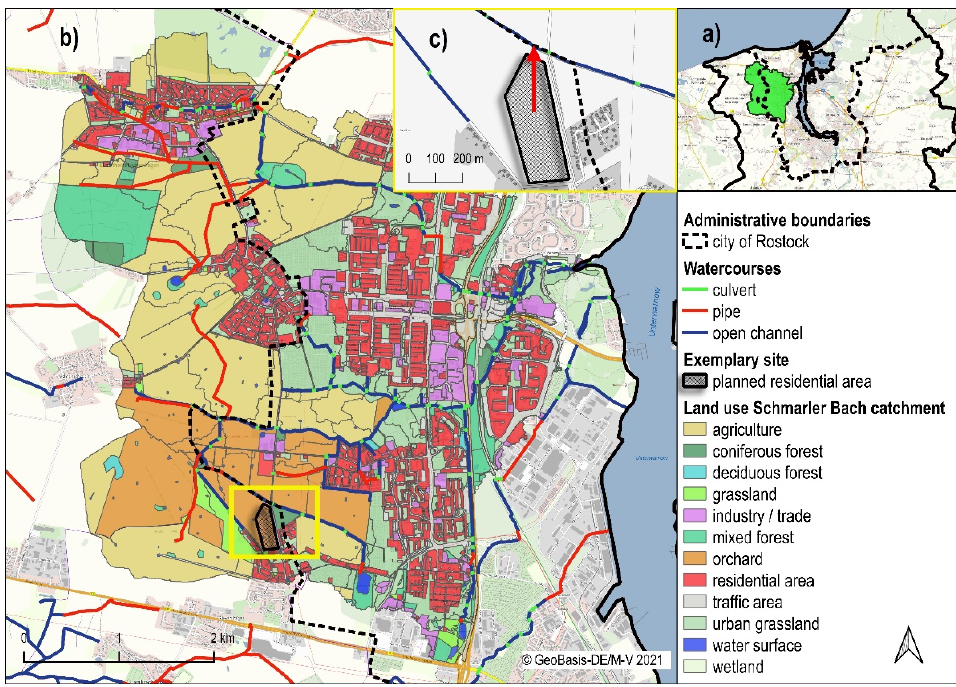
Figure 5. Schmarler Bach area with land use of the actual state. ( a ) Outline map, ( b ) complete Schmarler Bach catchment with the exemplary planned residential area in the central south (yellow box), ( c ) detail section of the planned residential area.